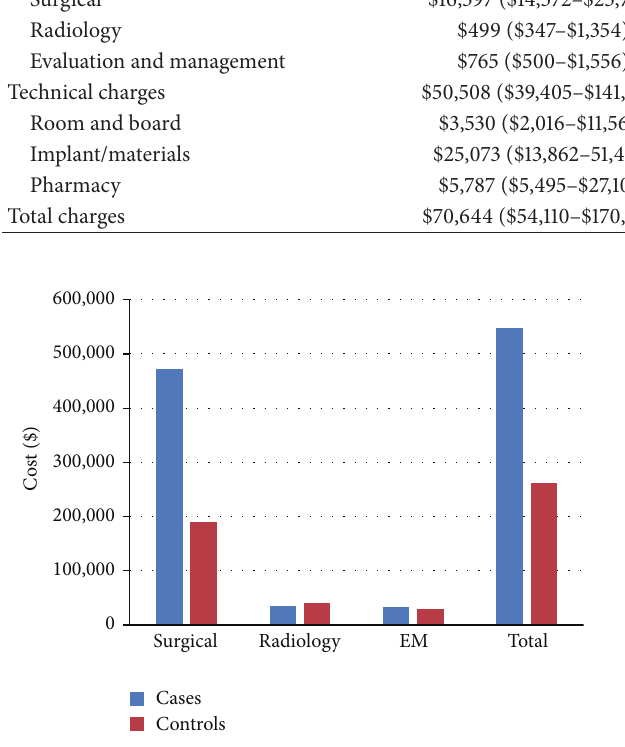
Figure 2: Aggregate technical charges for cases and controls are broken down into diagnostic, room at board (R&B), surgical materials and implants (materials), pharmacy, and total charges. Median values are